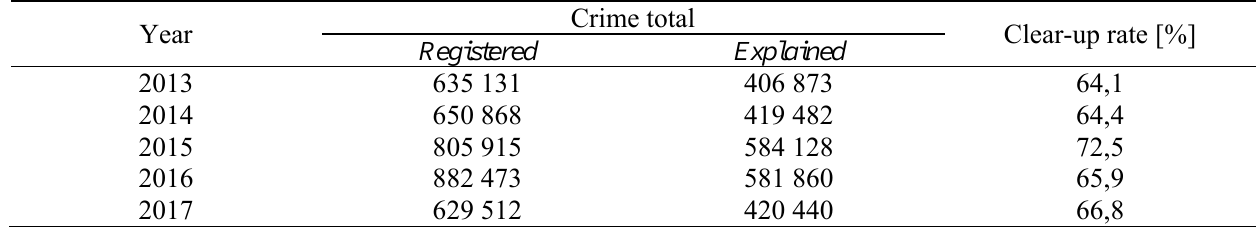
Table 1. Development of the number of crimes and their clear-up rate in the Bavaria region [adopted from